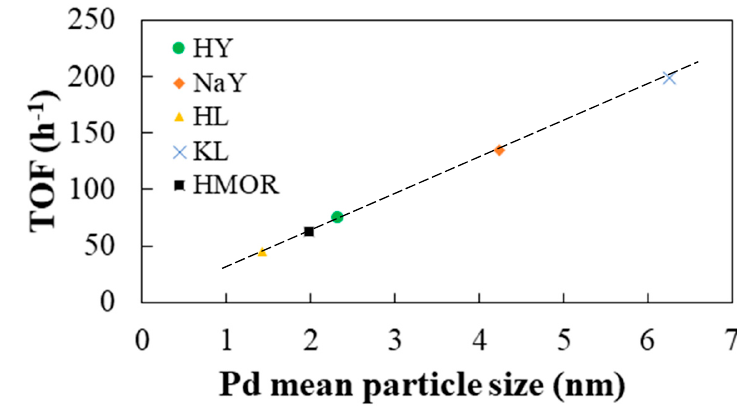
Figure 7. Turnover frequency (TOF) (50% conversion) versus mean particle size for the hydrodechlorination (HDC) of DCM and